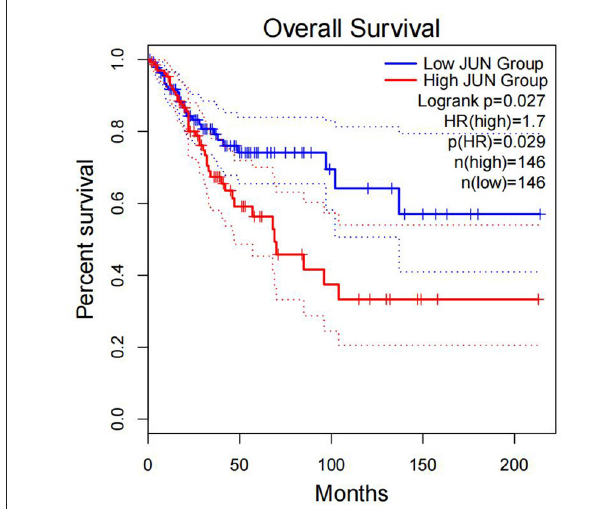
FIGURE 10 | Correlation between the expression of JUN and OS. Overall survival was inferior in patients with high JUN expression.